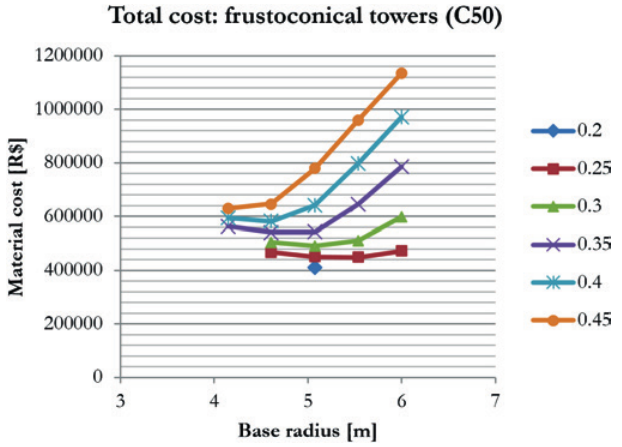
Composition of the total cost for frustoconical towers (C50) of constant thickness (35 cm)